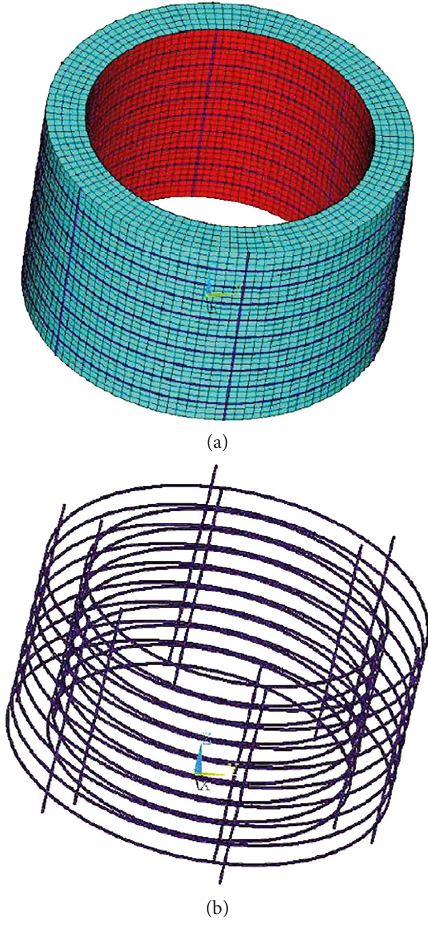
Figure 15: Finite element model of